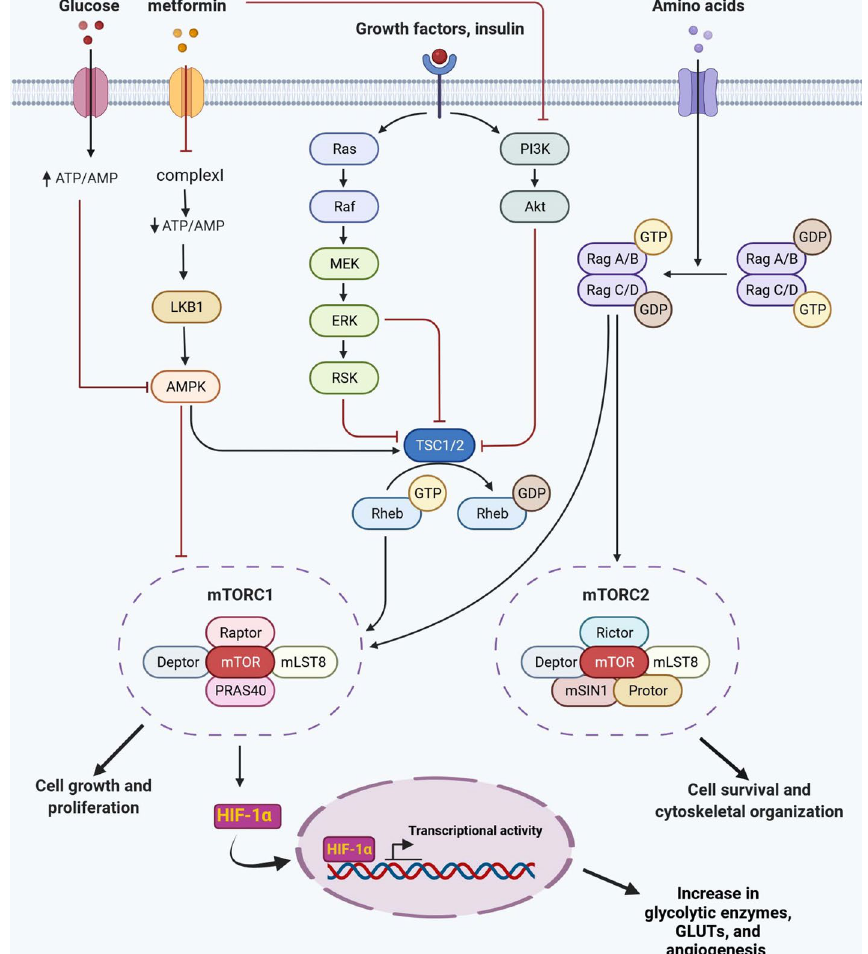
Fig. 3 Metformin and oncosignaling pathways. The main anti-proliferative effect of metformin depends on inhibition of mTORC1. Inhibition of mitochondrial complex I by metformin and decreased ATP/ AMP ratio activates the LKB1/AMPK pathway. AMPK is one of the main inhibitors of mTOR by activating TSC1/2 and downregulates mTORC1. However, the PI3K/AKT/mTOR axis is also inhibited by metformin (AMPK-independent manner). Although increased nutrients, such as amino acids and glucose, activate proliferation via mTOR activation, lack of metabolites inhibits cellular growth and division (not shown). GDP Guanosine-5 ′ -diphosphate, GLUT glucose transporter, GTP Guanosine-5 ′ -triphosphate, mTOR mammalian target of